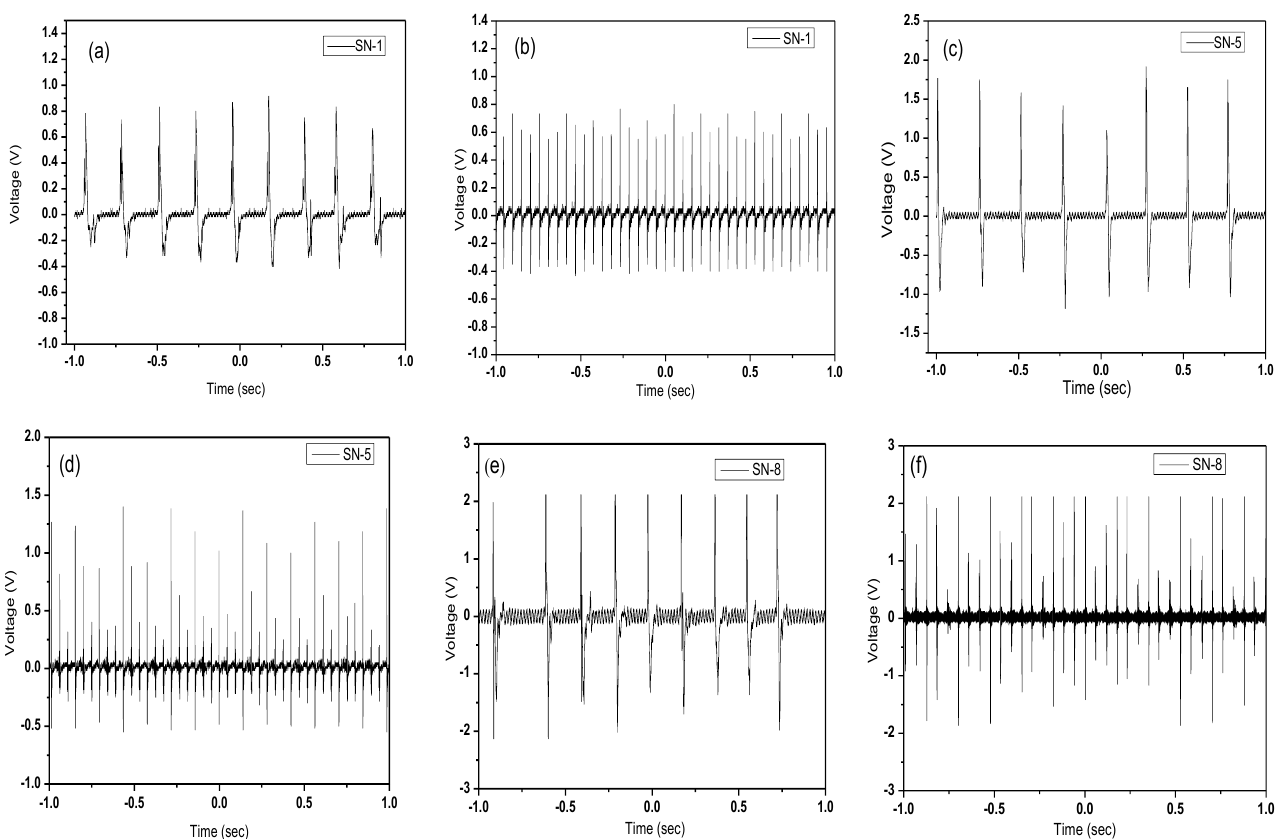
Figure 8. Open-circuit voltage under continuous hand pressing ( a ) PVDF-SN-1, ( c ) PVDF/ZnO-SN-5, ( e ) PVDF/ZnO-SN-8. Open-circuit voltage under continuous hitting ( b ) PVDF-SN-1, ( d ) PVDF/ZnO-SN-5, ( f ) PVDF/ZnO-SN-8. Table 2. Electrical response of prepared PNGs.